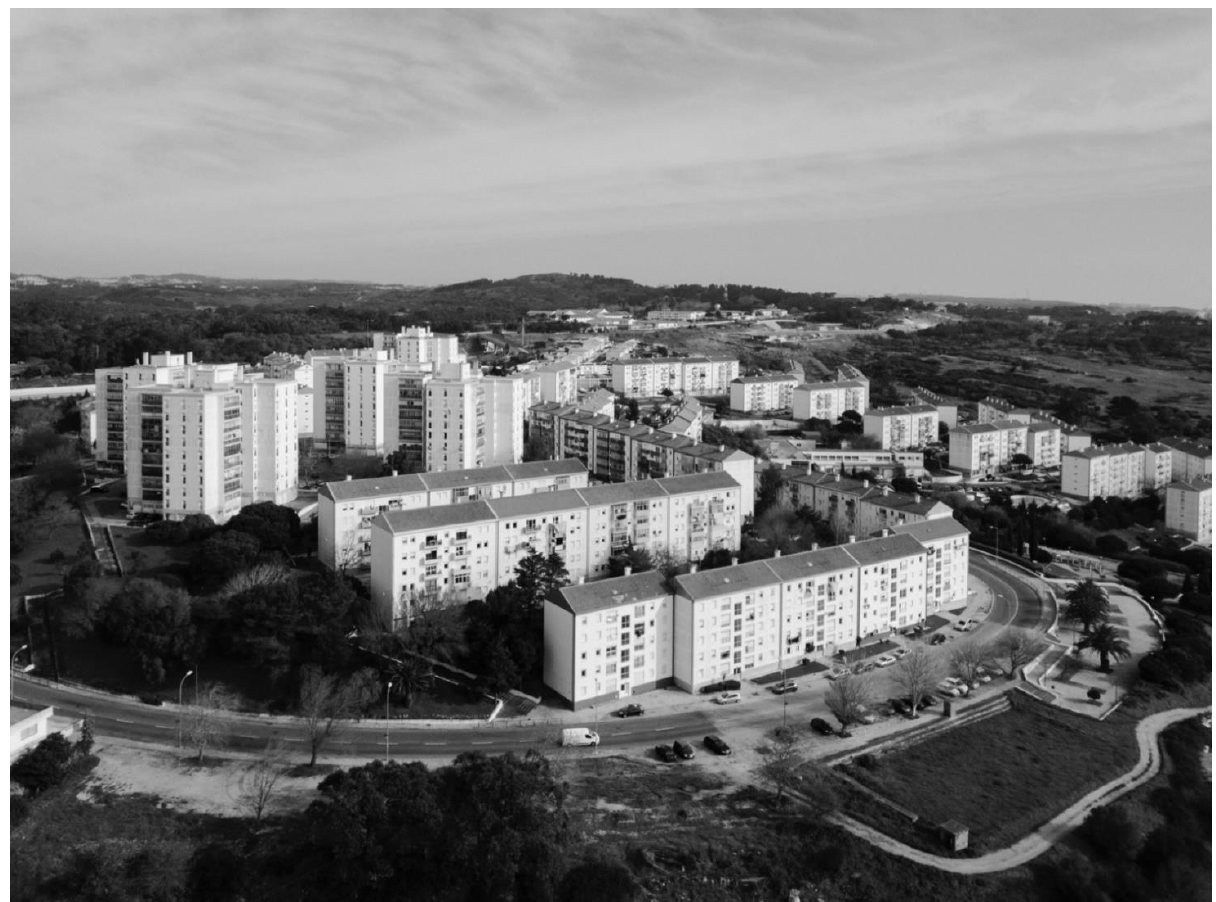
Figure 1. Affordable Houses Estate in Mira-Sintra (Agualva-Cacém)/ICESA neighbourhood, 1965, João Abel Manta, Alberto Pessoa, Gonçalo Ribeiro Teles (MdH BD a267). MdH and Tiago Casanova.